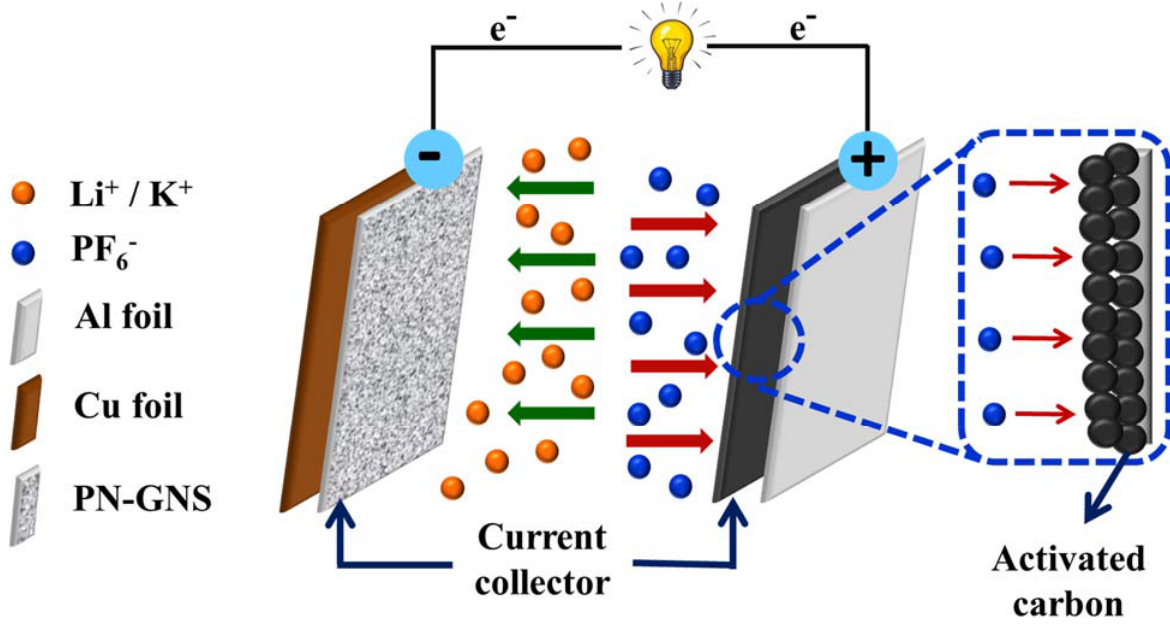
Figure 8. Schematic diagram of lithium-ion batteries.